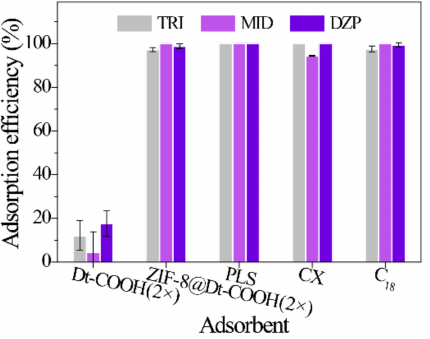
Figure 5. Effect of different SPE sorbents on the adsorption efficiency of three BZDs ( n = 3). Log P (octanol–water partition coefficient) refers to the ratio of the solubility of a compound in octanol/water to assess the hydrophobicity of a compound. The higher log P value, the stronger the hydrophobicity of the compound. The enhancement factor (EF) of all BZDs was calculated by comparing the extracted analytes concentration with that in the original urine sample. As shown in Table 1, DZP with the highest log P value (4.02) offers an EF of 30.0, while TRI with the lowest log P value (3.67) gives an EF of 27.8, indicating that the hydrophobic interaction between ZIF-8@Dt-COOH(2 × ) and BZDs play the